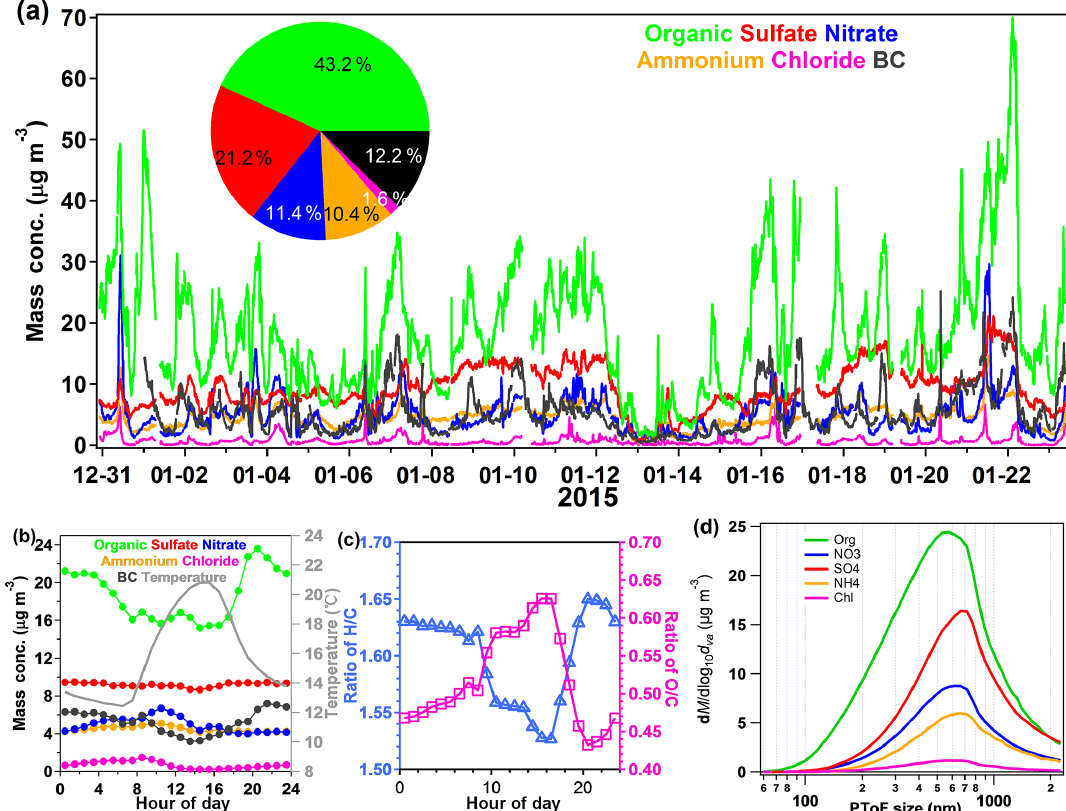
Figure 2. Chemical composition for only bypass conditions: (a) time series and the mass percentages of PM 1 composition; (b) diurnal variation in PM 1 species and ambient temperature; (c) diurnal variation in H / C ratio and O / C ratio; (d) average size distribution of non- refractory PM 1